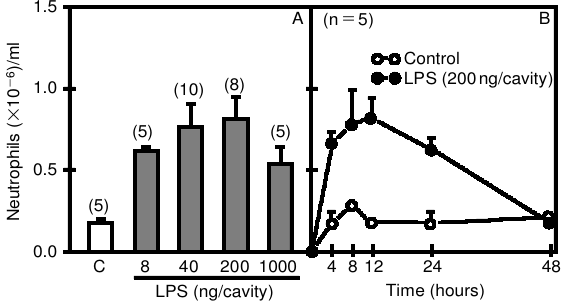
FIG. 1. Dose response and time course of neutrophil migra- tion induced by LPS. ( A ) Bars represent neutrophil migra- tion induced by the indicated doses of LPS into peritoneal cavities of mice. The control (C) represents neutrophil migration induced by saline solution. The neutrophil migra- tion was analysed 6 h after the injection of the stimuli. The number of animals per experimental group is indicated at the top of the bars. ( B ) Time course of neutrophil migration induced by either LPS (200 ng/cavity) or saline solution (control group). The number of animals per group was ® ve. In both panels, the results are reported as mean